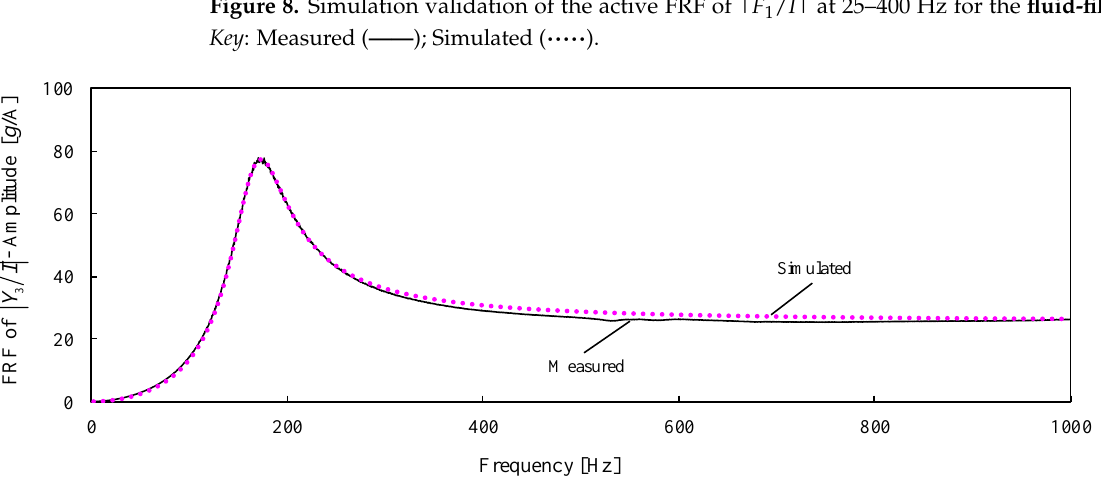
(cid:12) (cid:12) .. (cid:12) (cid:12) Y 3 / I (cid:12) (cid:12) at 0–1000 Hz for the non-fluid state . Y I at 0–1000 Hz for the non-fluid state . Key : 3 Y I at 0–1000 Hz for the non-fluid state . Key : 3